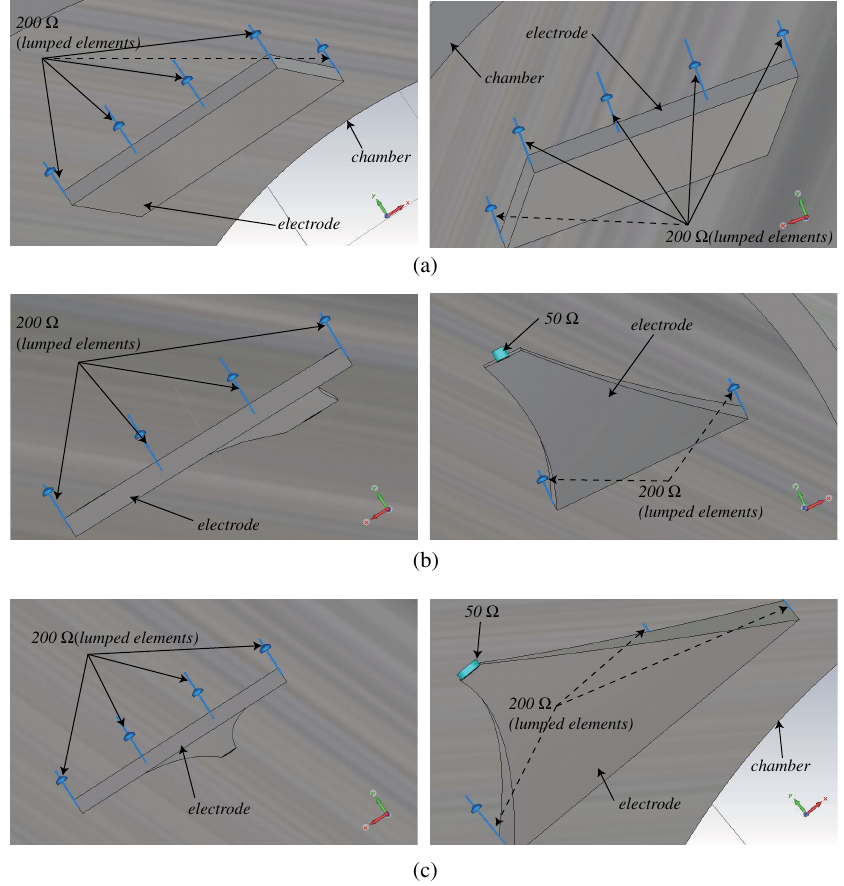
FIG. 7. A schematic picture of the electrode, where the ends are terminated with resistors in the vacuum chamber. (a) The rectangular shape, where the left and the right parts show the upstream and the downstream sides, respectively. (b) The exponential shape, where the left and the right parts show the upstream (wider) and the downstream (narrower) ends, respectively. (c) The polynomial shape, where the left and the right parts show the upstream (wider) and the downstream (narrower) ends,